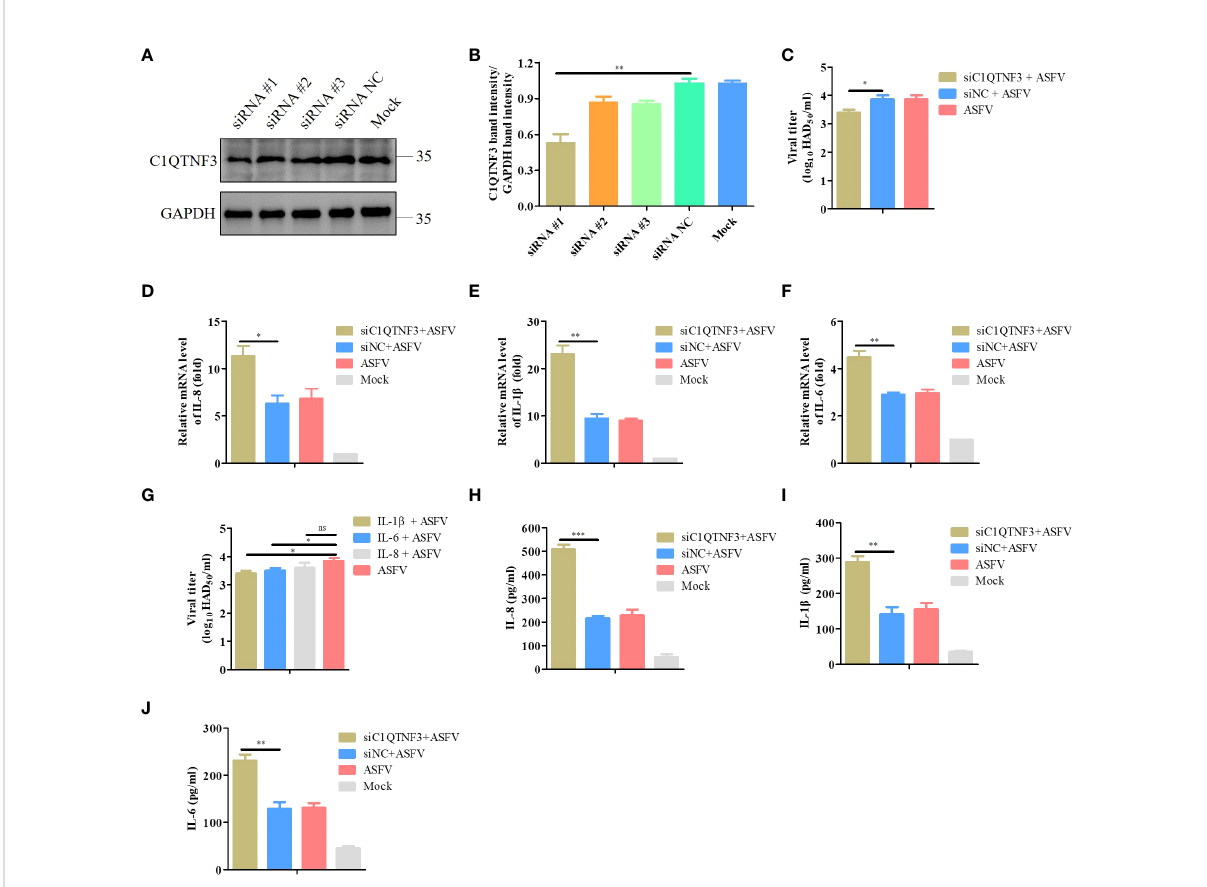
FIGURE 5 Upregulated pro-in fl ammatory cytokines inhibit ASFV infection in PAMs. (A, B) Detection of C1QTNF3 siRNA knockdown ef fi ciency using western blot analysis. (C) C1QTNF3 knockdown in PAMs inhibits ASFV replication as detected using the HAD assay. The mRNA levels of (D) IL-8, (E) IL-1 b , and (F) IL-6 upon C1QTNF3 knockdown in PAMs infected with ASFV. The GAPDH gene was used as the internal control for normalization. The 2 - DD Ct method was used to analyze the results of qPCR. (G) Porcine IL-1 b , IL-6, and IL-8 proteins inhibit ASFV replication, as detected using the HAD assay. The protein levels of (H) IL-8, (I) IL-1 b , and (J) IL-6 upon C1QTNF3 knockdown in PAMs infected with ASFV p <0.05 (*), p < 0.01 (**), and p < 0.001 (***), ns means no